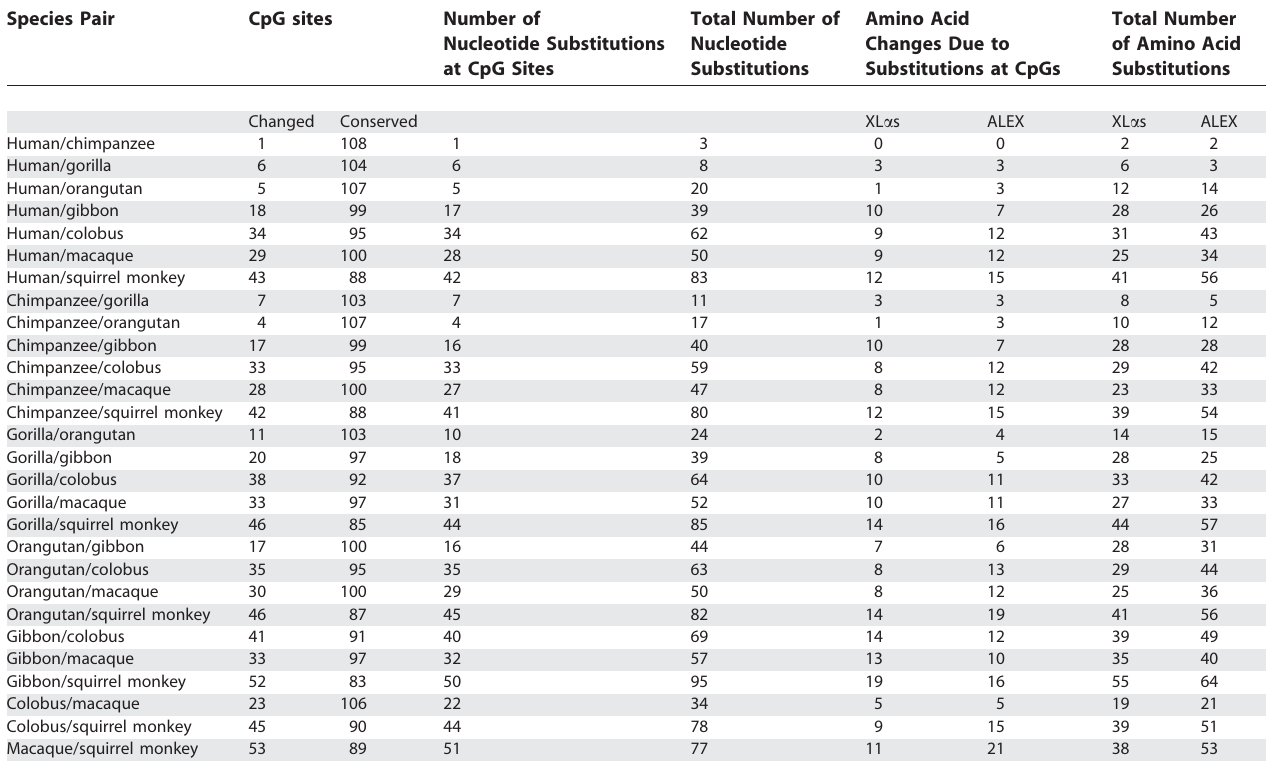
Table 3. Nucleotide and Amino Acid Replacements at CpG Sites Species Pair CpG sites Number of Nucleotide